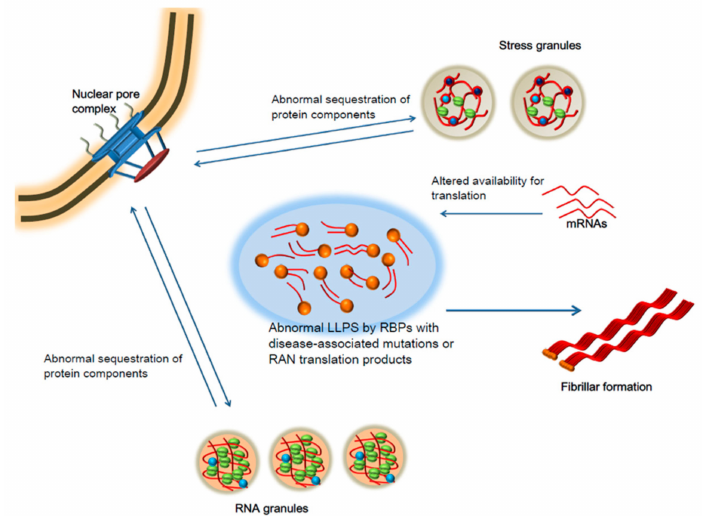
Figure 4. Aberrant LLPS and neurodegeneration. LLPS is now known to play a critical role in a growing number of biological processes and regulates the dynamics of various membraneless organelles in the cell. However, it has been demonstrated recently that aberrant LLPS dynamics caused by either disease-associated mutations of RNA-binding proteins or RAN translation products involved in numerous neurodegenerative diseases contribute significantly to the neurotoxicity via several di ff erent mechanisms. LLPS formed by mutant proteins or RAN translation products can: (1) disrupt existing membraneless organelles including the nuclear pore complex, stress and RNA granules; (2) sequester RNAs and proteins which are not normally part of the LLPS assemblies or disturb their exchange dynamics such that their normal functions are disrupted (e.g., mRNA translation may be decreased by the reduced availability of certain transcripts or translation factors); and (3) LLPS assemblies can further undergo conformational changes and ultimately lead to the formation of fibrillar aggregates, further disturbing proteostasis in a ff ected